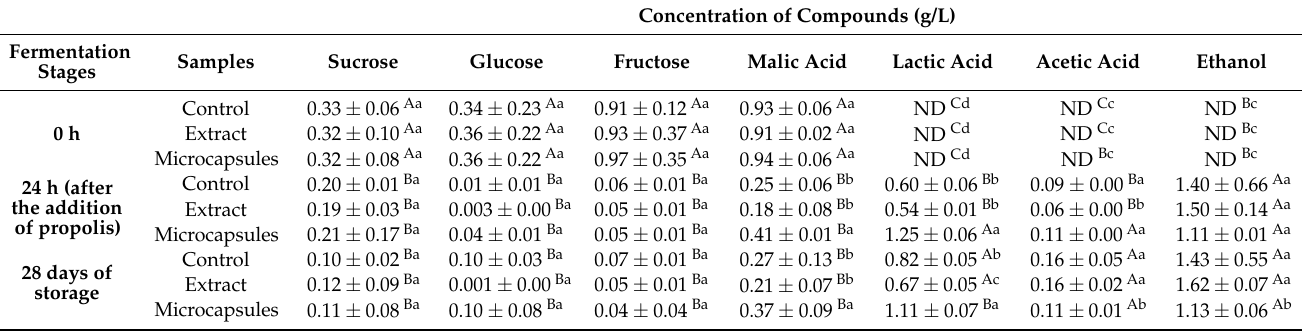
Table 1. Concentration of carbohydrates, organic acids, and alcohols in non-dairy beverages plus propolis (Figures S1 and S2; Table